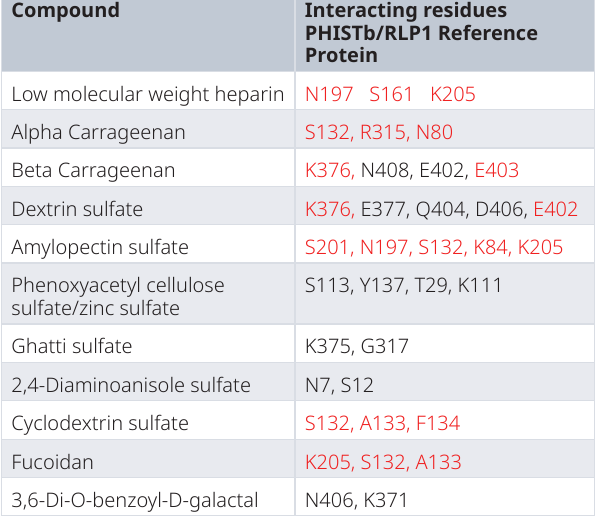
Table 9. Specific amino acids of the PHISTb/RLP1 mutant protein interacting with different drug compounds at different clusters of the active sites. The highlighted residues are specific amino acids predicted by the binding sites predicted amino acids in the mutant protein binding sites. The other compounds interacted with amino acids within the PHIST and RESA domains of the protein. These interactions revealed potential activity of these compounds as inhibitors of PHISTb/ RLP1 protein from carrying out its functions.